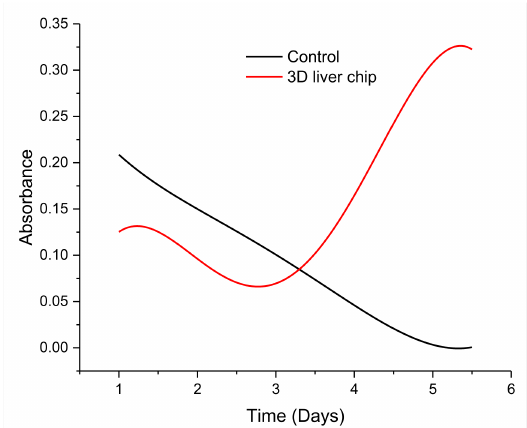
Figure 7. Absorbance monitoring during liver cell culture.